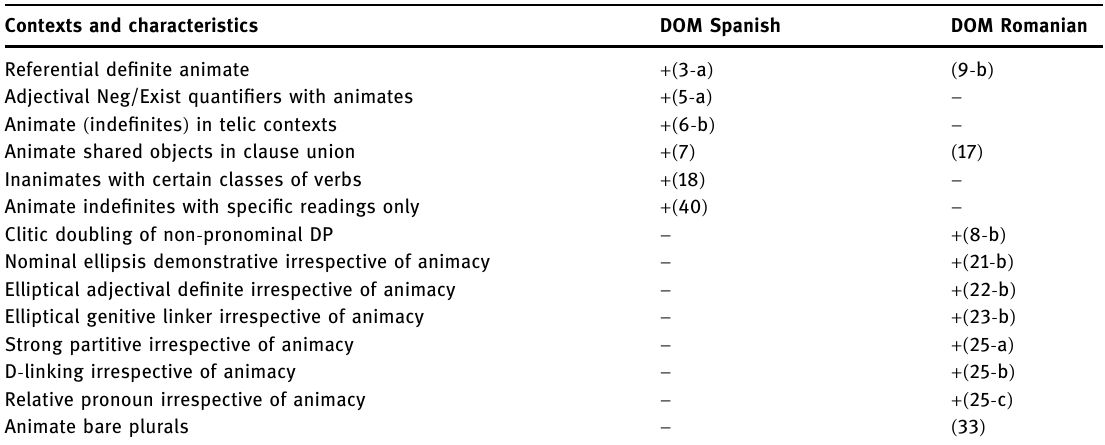
Table 9: DOM points of divergence – standard Spanish and Romanian Contexts and